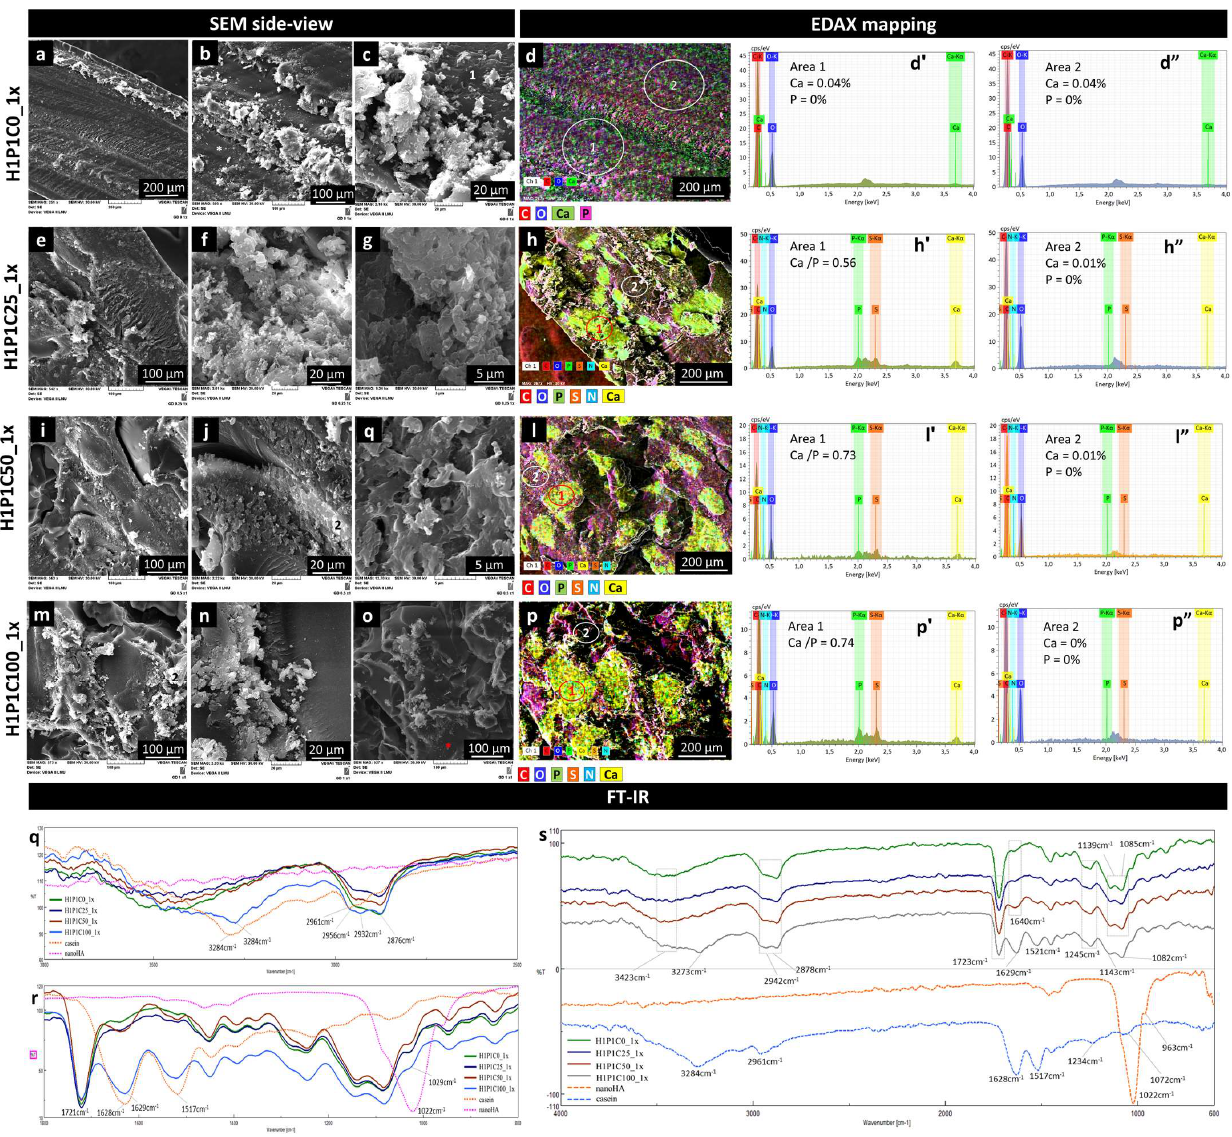
Figure 6. Representative SEM micrographs ( a , b , c , e , f , g , i , j , k , m , n , o ) and EDAX mapping ( d , h , l , p ) exploring microstructural changes after 1 cycle of mineralisation: H1P1C25, H1P1C50, H1P1C100 hybrids with increasing casein content. H1P1C0 hydrogel was used as a control; individual colour codes are displayed for elements identified by EDAX; representative EDAX spectra for mineralised area 1 in the microelemental maps ( d’ , h’ , l’ , p’ ) and for hydrogel matrix in area 2 in the microelemental maps ( d” , h” , l” , p” ); FTIR spectra recorded onto the surface: wavenumber interval 3000-2500 cm −1 ( q ), wavenumber interval 1800-800 cm −1 ( r ) and whole range spectra ( s ).